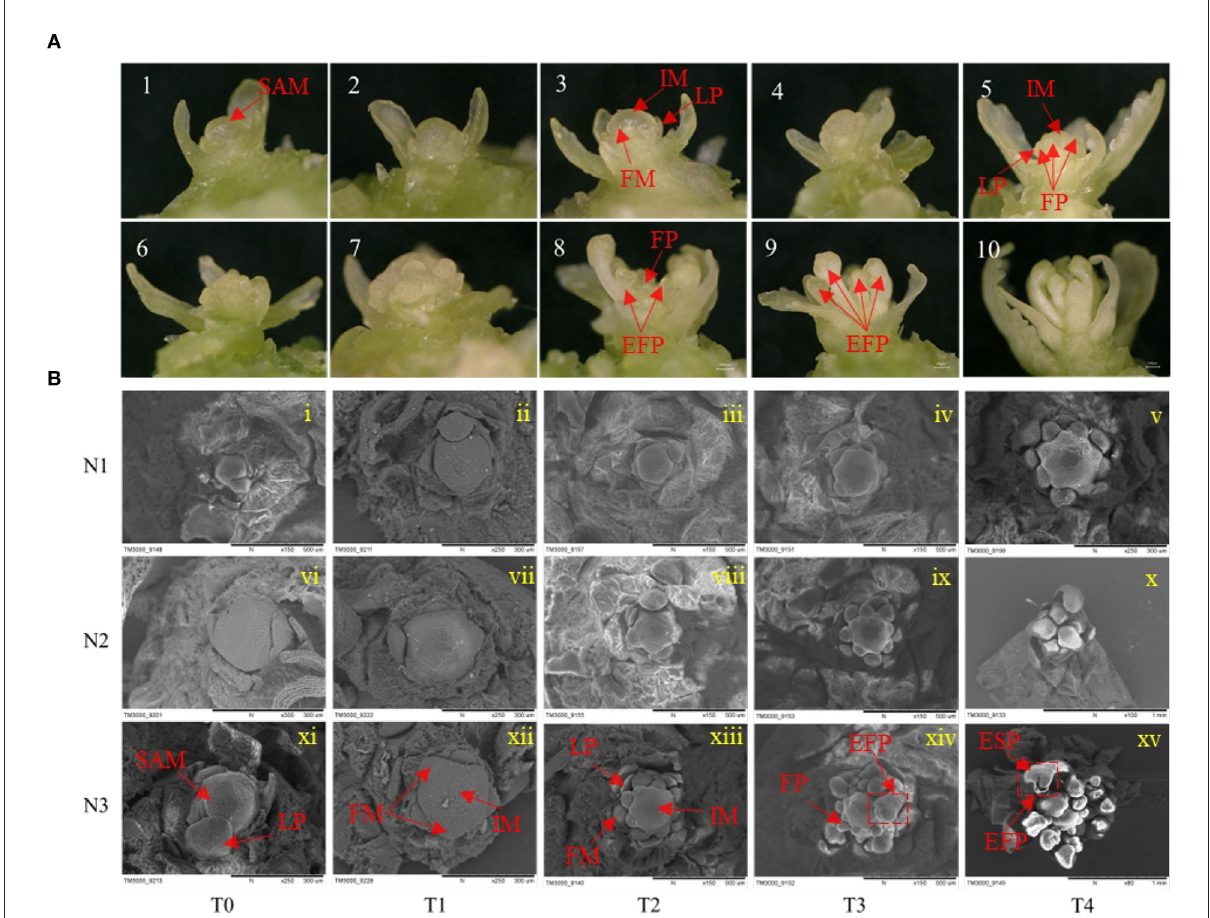
FIGURE2 Effects of low N (N1), formal N (N2), and high N (N3) rates on the morphology of shoot apical meristems and floral meristems. (A) display of 10 consecutively different images of the development of rapeseed inflorescence and floral meristems under a stereoscope. (B) Scanning electron microscope images of inflorescence and floral meristems at T0, T1, T2, T3, and T4 sampling stages under low N (N1), normal N (N2), and high N (N3) rates. EFP, elongated floral primordium; ESP, elongated sepal primordium; FM, floral meristem; FP, floral primordium; IM,